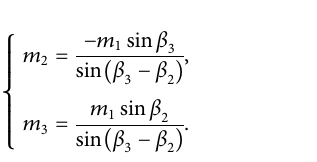
Using Eq. 9 one can calculate the values of m 2 and m 3 , which allow to obtain the desired ( β 2 , β 3 ) phase – locked synchronous con fi guration. The solutions of (9) have the physical sense only when both formulas are greater than zero; the regions of ( β 2 , β 3 ) values corresponding to such scenario are shown in Figure 6C in black. The presented map allows to determine which values of the phases (the ones corresponding to the black domain) can be